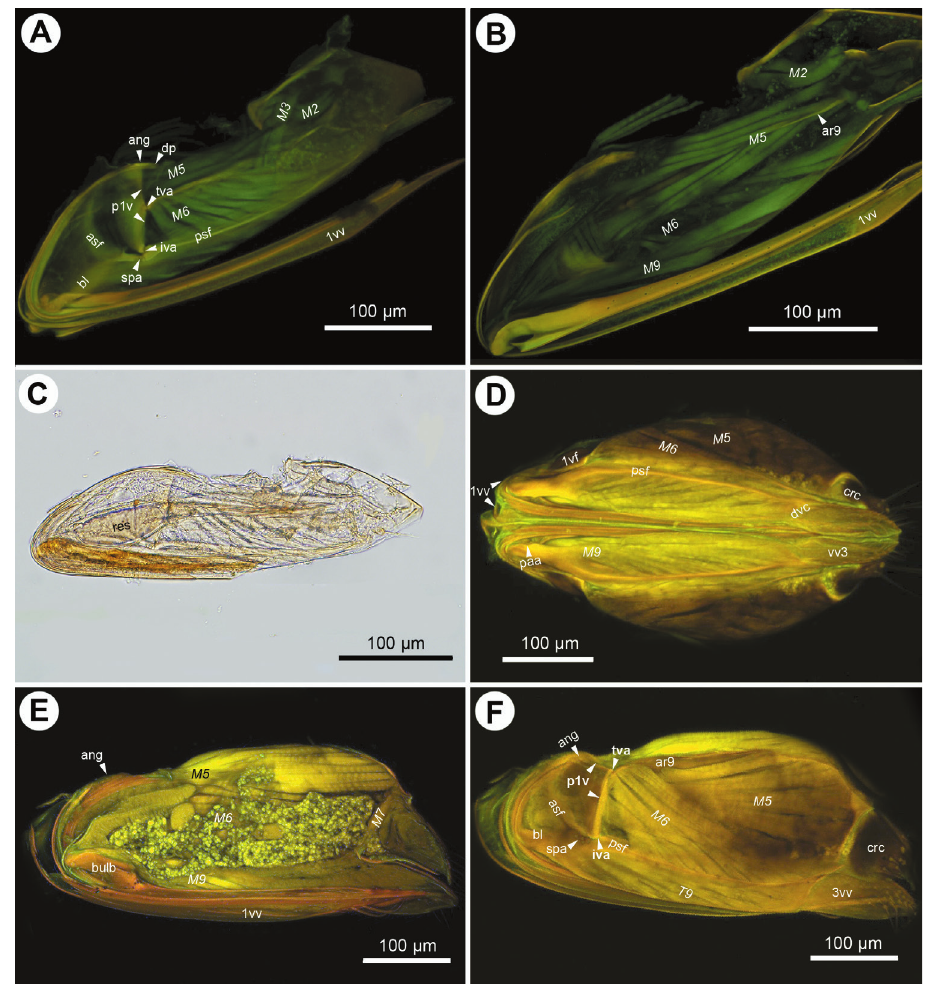
Figure 4. CLSM micrographs and bright field image showing the female terminalia of Megaspilidae. A–C: Lagynodes sp.: A CLSM, lateral view (doi: 10.6084/m9.figshare.156443) B CLSM, medial view (doi: 10.6084/m9.figshare.156454) C bright field, medial view. D–F Dendrocerus spissicornis (Hellén), CLSM: D ventral view (doi: 10.6084/m9.figshare.156451, doi: 10.6084/m9.figshare.156449) e medial view (doi: 10.6084/m9.figshare.156452) F lateral view (doi: 10.6084/m9.figshare.156459, doi: 10.6084/ m9.figshare.156450). All anterior to